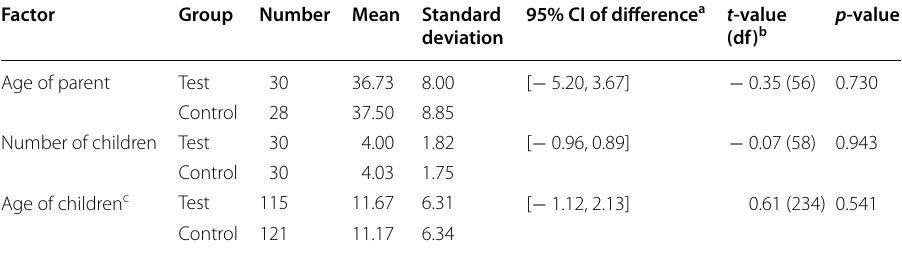
a Difference was calculated as Test–Control. CI, confidence interval b df, degrees of freedom c All the children in all the families in each group were considered in these